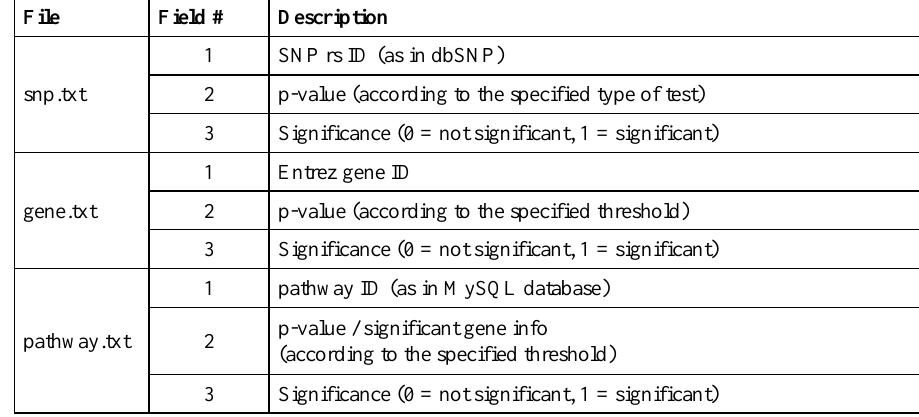
Table 1: Output files created at the end of genome wide association